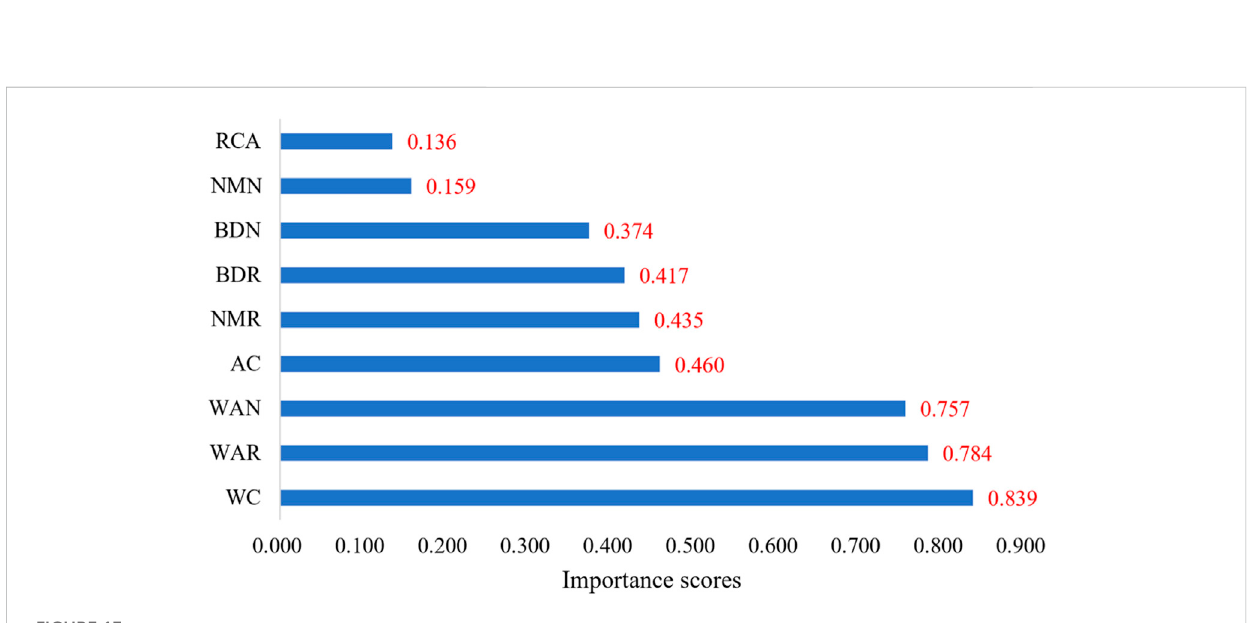
FIGURE 13 The importance scores of the input